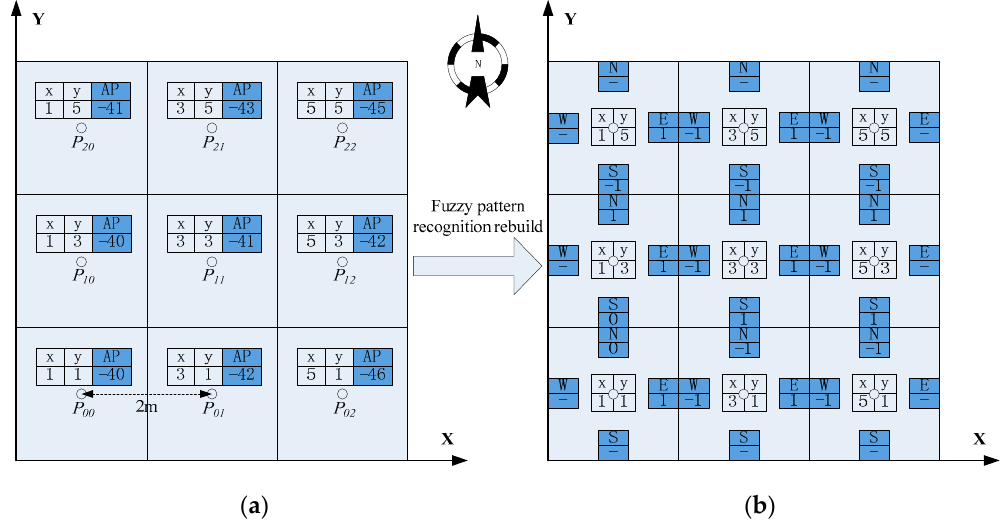
Figure 6. The comparison of two kinds of radio maps: ( a ) the pre-existing radio map; ( b ) the reconstructive radio map.